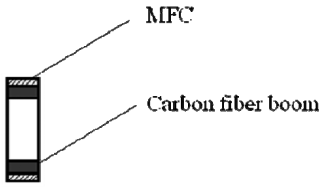
Fig. 5. Carbon fi ber boom segment attached to